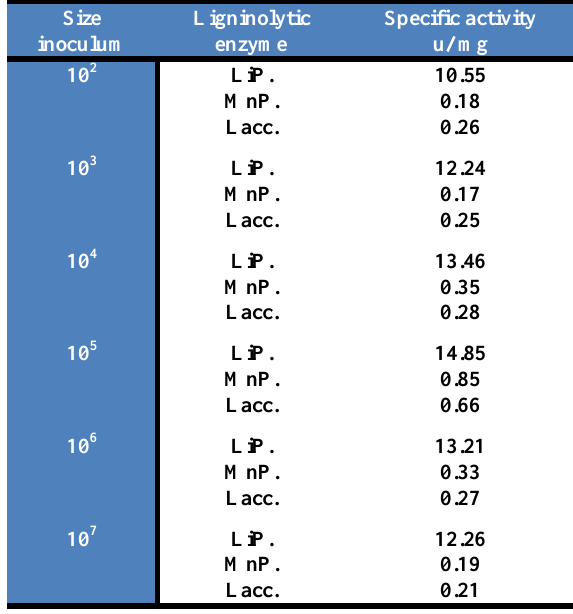
Table, 7: Ligninolytic enzymes production by use different size of